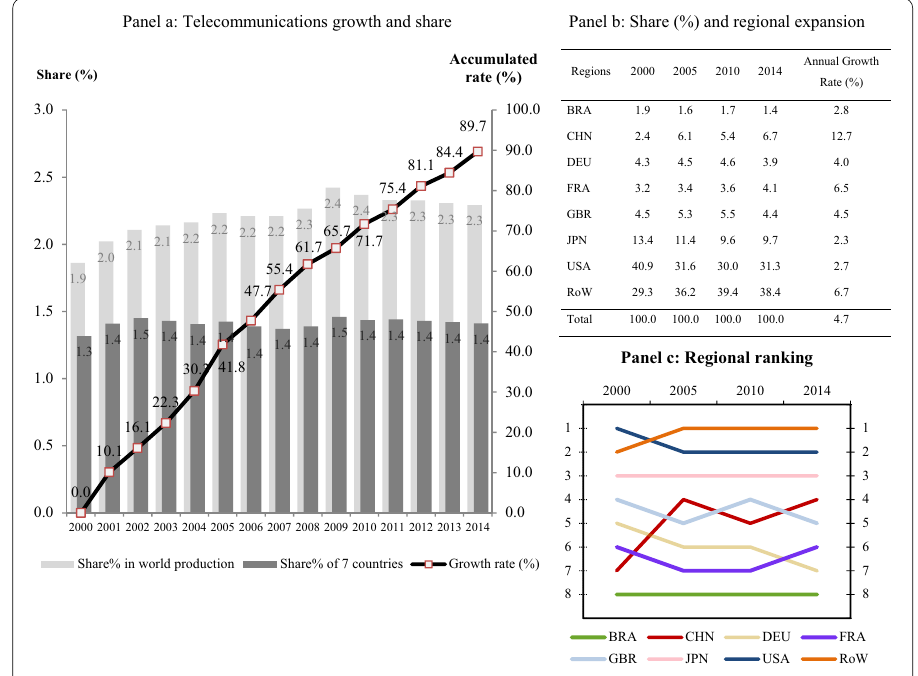
Fig. 1 Telecommunications’ output in the world between 2000 and 2014. Source: WIOD. BRA: Brazil;